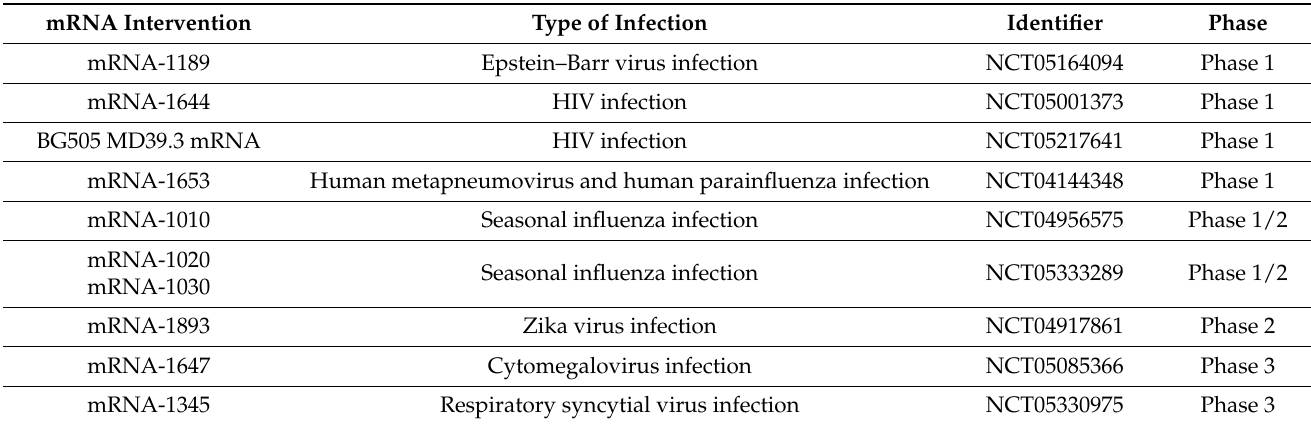
Table 1. Representative list of clinical trials in the United States investigating new mRNA-based